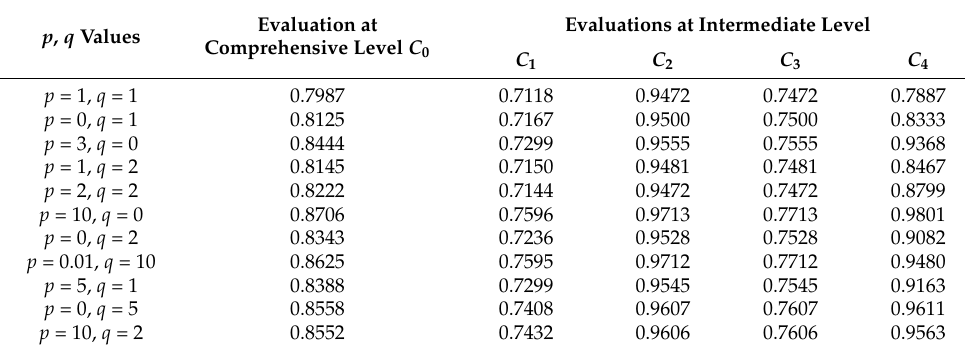
Table 5. Evaluation of the home environment with different p and q values. p , q